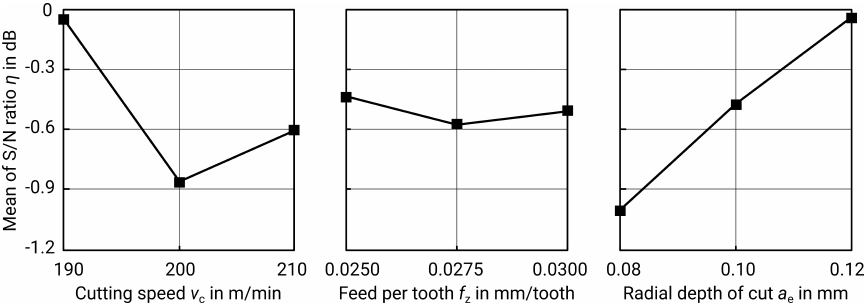
Figure 12. Main effect plot for S/N ratios for S a of milled horizontal surfaces.